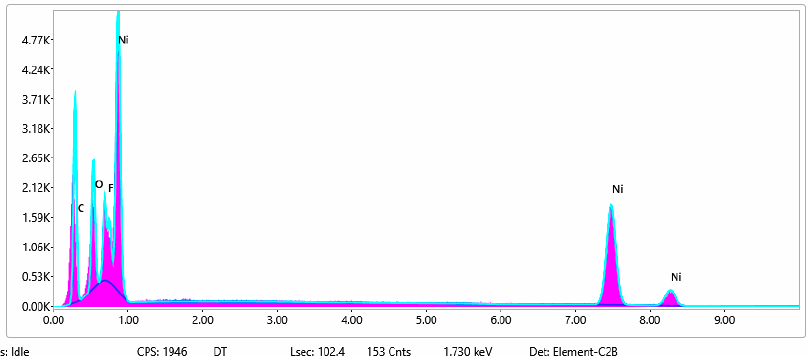
Figure 6. EDS spectra for sample 3 (fabric treated using a preliminary classical cleaning method and